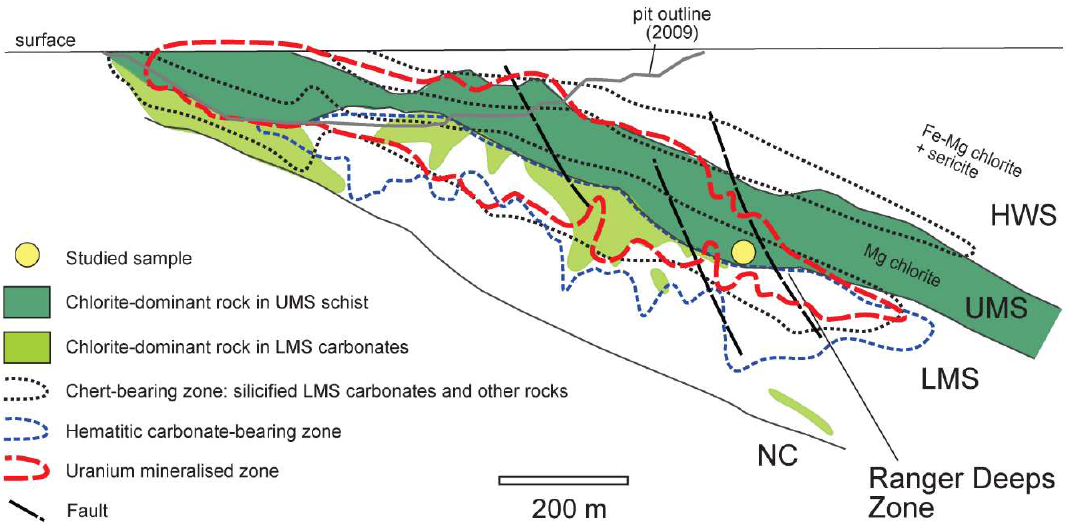
Figure 2. Generalised east–west cross sections of lithology, alteration and location of the sample investigated, at the Ranger 1 No 3 orebody (Australia). Modified from Skirrow et al. [4]. UMS: Upper Mine Sequence; LMS: Lower Mine Sequence; HWS: Hangingwall